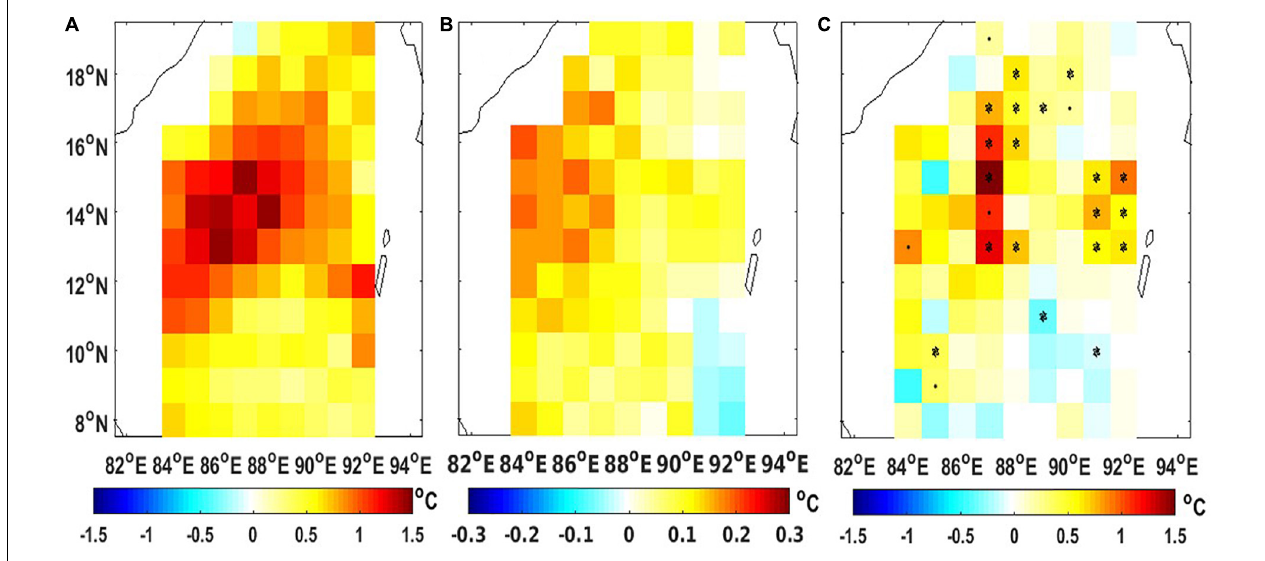
FIGURE 4 | (A) The observed spatial pattern of change in SST. (B) Change in SST calculated using method 1. (C) Change in SST estimated using method 2 (dots and stars represent statistical significance at 90 and 95% levels, respectively).